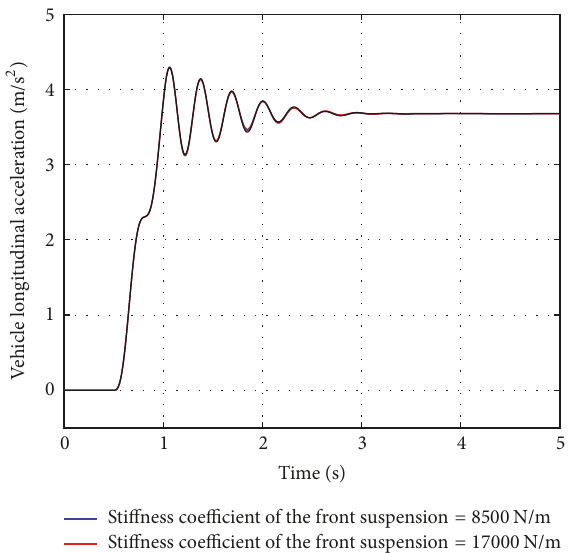
Figure 14: Longitudinal acceleration with/without pitch and sus- pension vertical vibration. Figure 15: Sensitivity analysis: effect of the variation of suspension